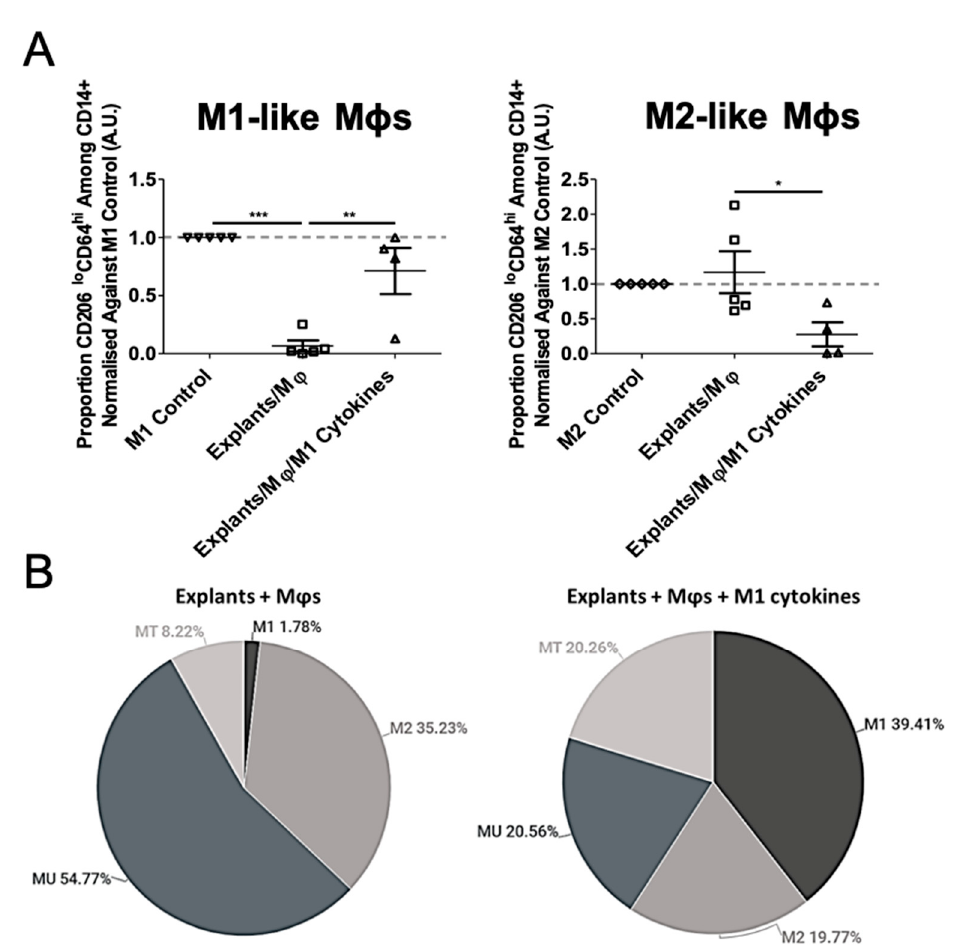
Figure 3. Explant-induced M2-like M ϕ polarisation is reversed upon LPS and IFN γ treatment. ( A ) To test the plasticity of the explant-induced M2-like phenotype, explant-conditioned M ϕ co-cultures were treated in parallel with or without M1-promoting cytokines (20 ng/mL IFN γ and 10 pg/mL LPS) for 48 h. Each symbol represents an individual patient. ( B ) Pie charts representing the proportion of CD14 + cells exhibiting an M1-, M2-, MU-, and MT-like phenotype following 48 h ex vivo culture with explants in the absence ( left ) and presence ( right ) of M1-promoting cytokines. MT, Transitional myeloid cells; MU, Unpolarised myeloid cells. The p values were obtained from one-way ANOVA followed by post hoc Tukey test. Statistically significant differences were observed compared to the M2 control (M1-like M ϕ s) or M1 control (M2-like M ϕ s). Data were obtained from 5 independent experiments using patient blood and tissue and graphs show means ± SEM. * p < 0.05, ** p < 0.01, *** p < 0.001.